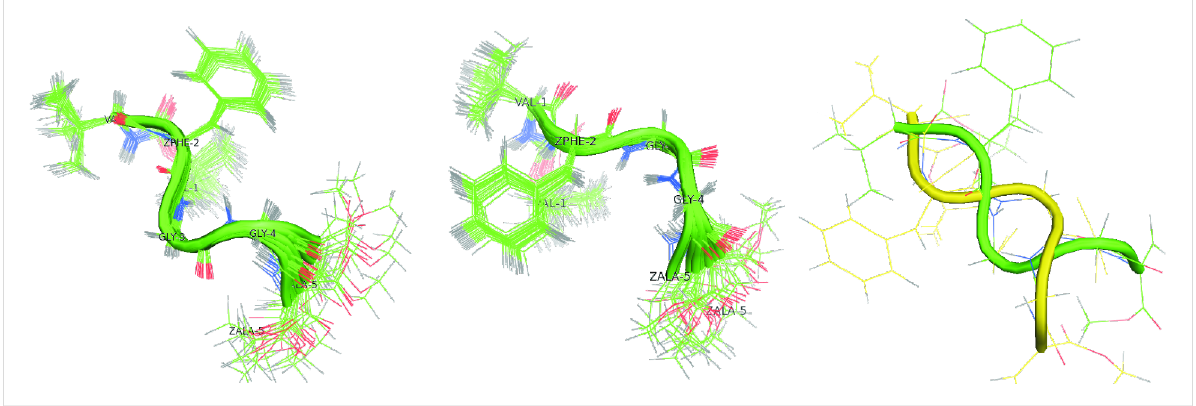
Figure 2: The most stable conformation of peptide 1 proposed based on XPLOR-NIH calculations. Conformation 1a (left), conformation 1b (middle) and a superposition of both conformations (right).